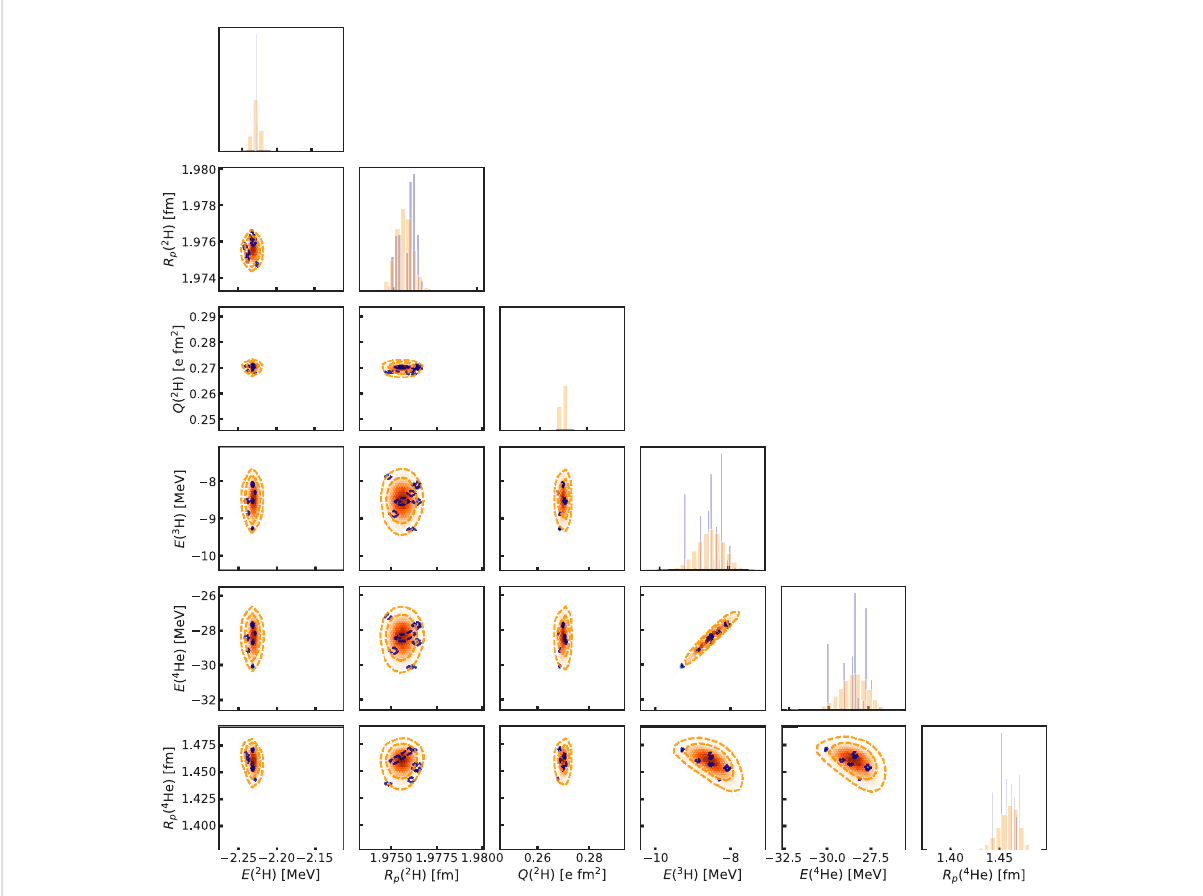
FIGURE 6 The PPD generated using S/IR (blue) and MCMC sampling (orange) for the posterior distributions shown in Figure 5. Marginal histograms of the observables are shown in the diagonal